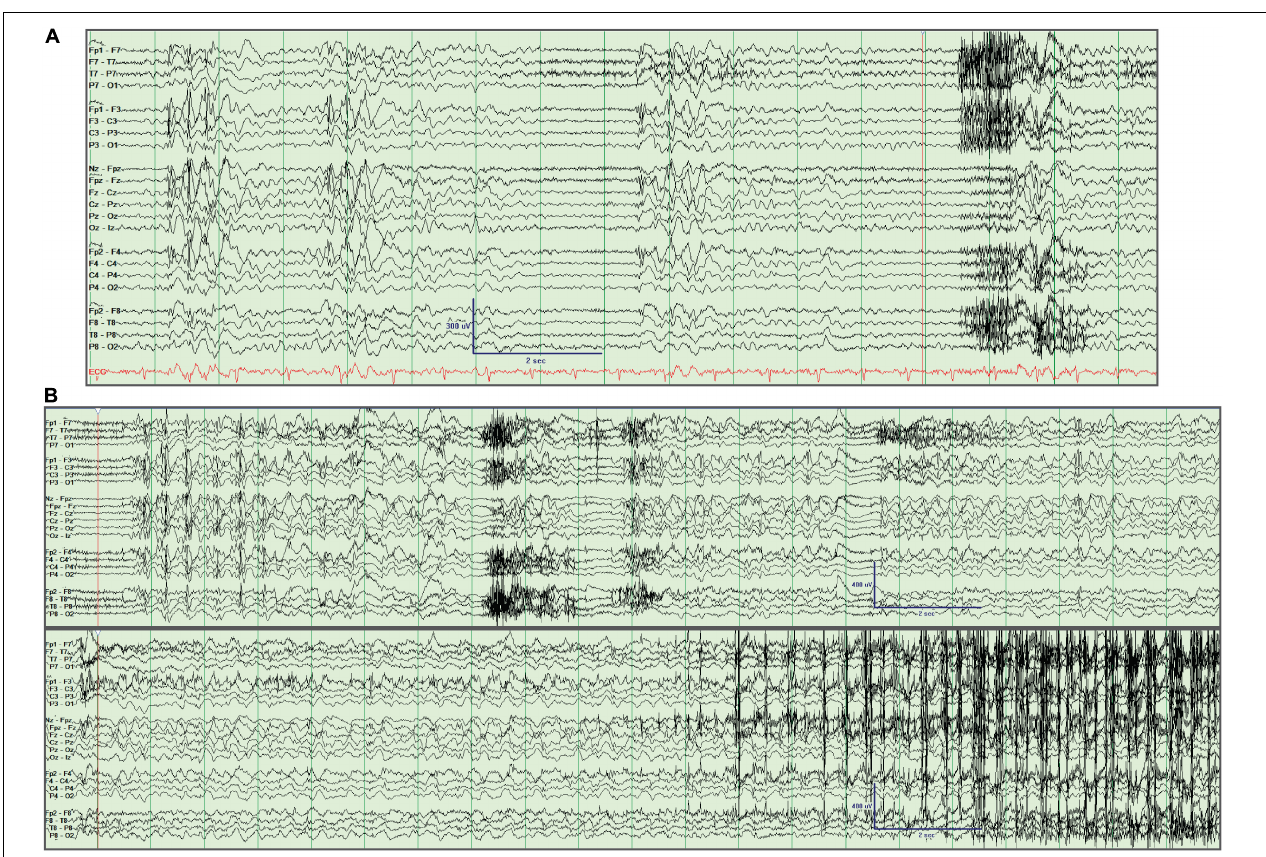
FIGURE 1 | Interictal and ictal EEG recording. (A) Generalized spike/polyspike and wave discharges. (B) Generalized onset clonic-tonic-clonic seizure. The seizure starts 2 s into the tracing and is seen in the continuation of the EEG in the lower panel, with evident clonic myogenic artifact near the end of the recording. This activity was preceded by recurrent bursts of generalized spike/polyspike and wave discharges. Longitudinal bipolar montage left over